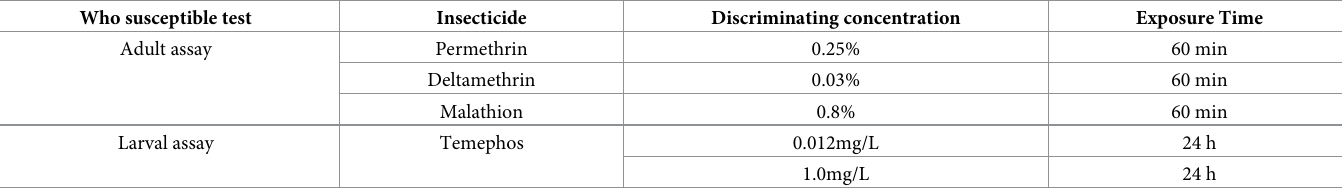
Table 1. Discriminating concentration of tested insecticides and the diagnostic time of insecticide exposure. Who susceptible